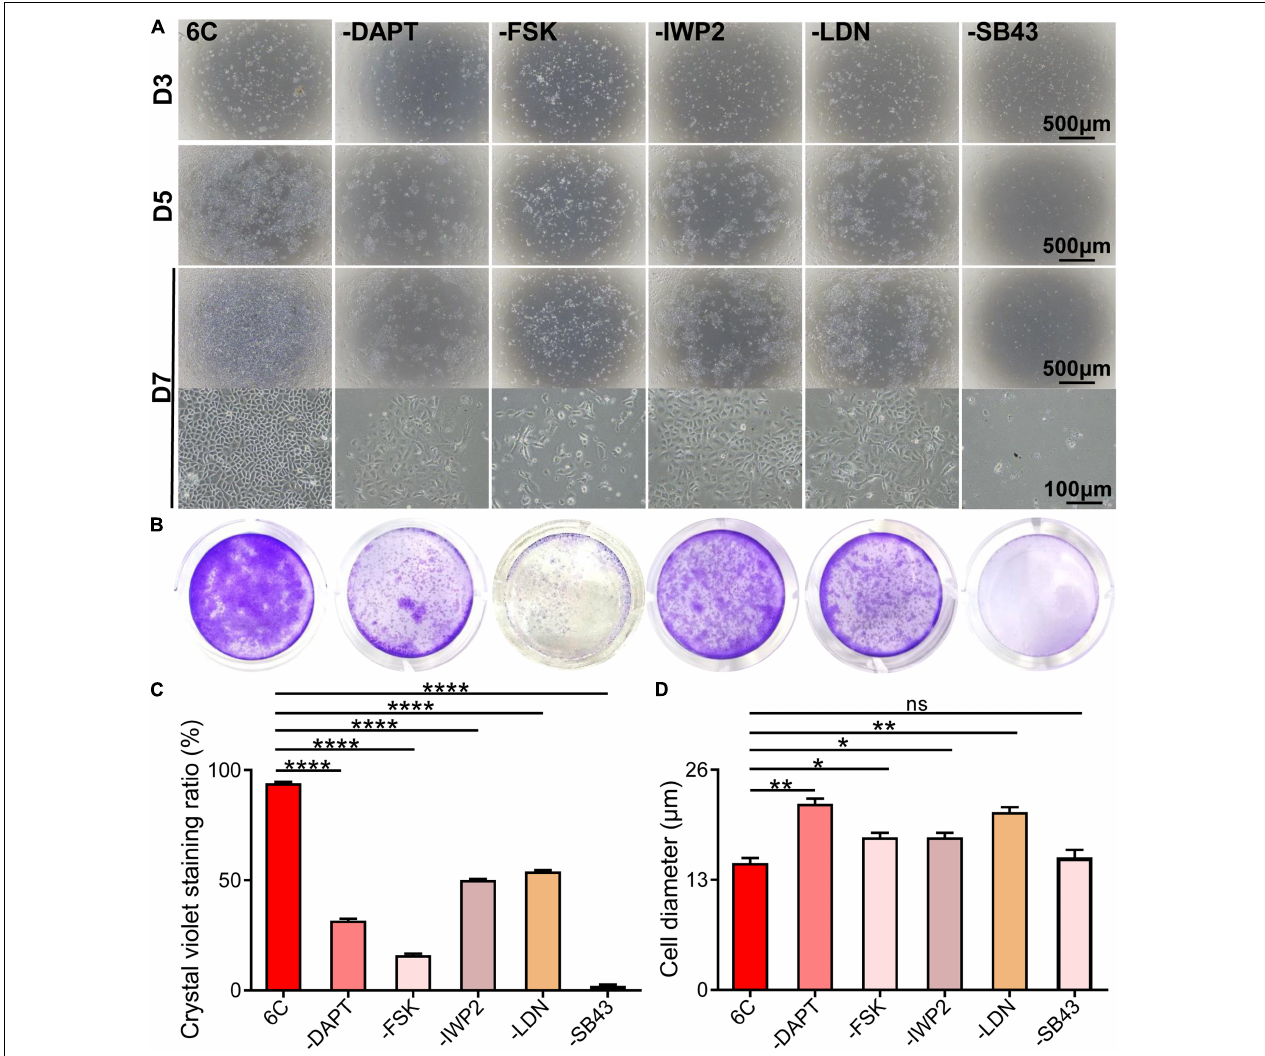
FIGURE 2 | Effects of subtracting a compound on the proliferation of mCEC. (A) Morphological comparison of mCEC cultured with subtracting one compound from 6C or 6C, respectively (The group without Y-27632 has been described above). Images were taken at day 3, day 5 and day 7 post seeding. The cell proliferation rate of the 6C treatment group was much better than that of the treatment group minus any compound. (B) Crystal violet staining results after 1 week of cell culture. 6C group had the most stained area. (C) Statistical analysis of crystal violet staining results. Data expressed as the means ± SEM from three separate experiments (* P < 0.05, ** P < 0.01, **** P < 0.0001, ns: no significance). (D) Statistical analysis of the diameters of the